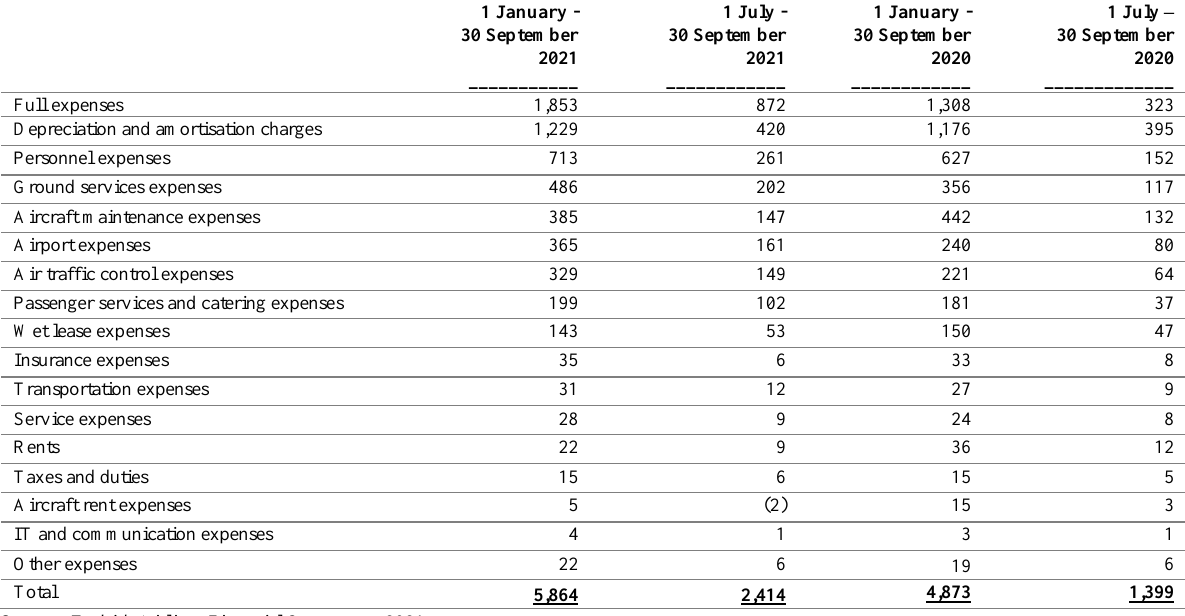
Table 1: Cost of Sales of Turkish Airlines in First Nine Months of 2021